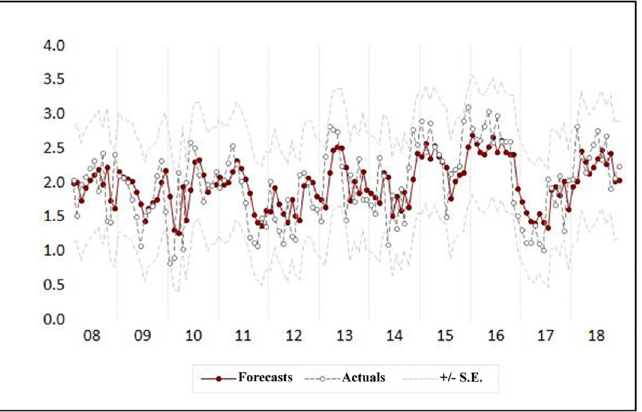
Fig 5. Comparison of forecasted and actual leptospirosis cases by univariate seasonal ARIMA model.